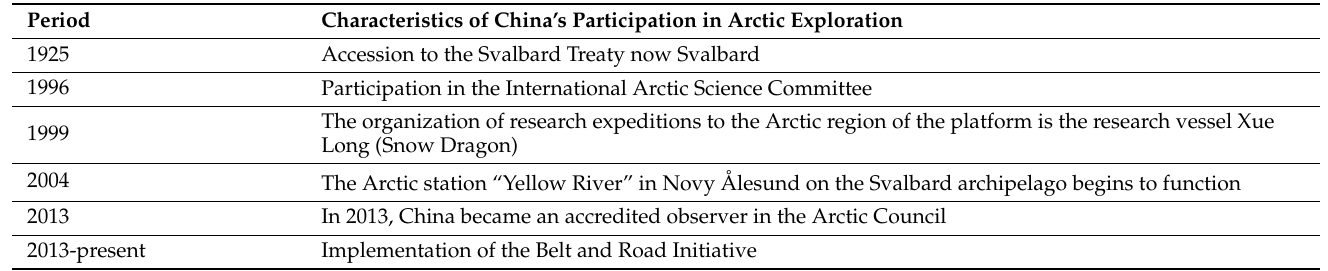
Table 6. The history of China’s presence in the Arctic begins in the first quarter of the XX